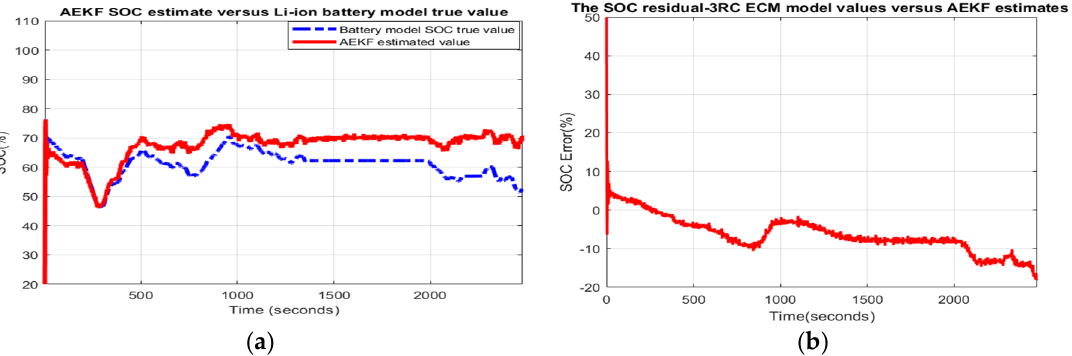
Figure 3. Robustness to simultaneous changes, SOCini = 0.2, and output temperature profile changes; ( a ) AEKF SOC value versus battery model true value; ( b ) SOC residual.